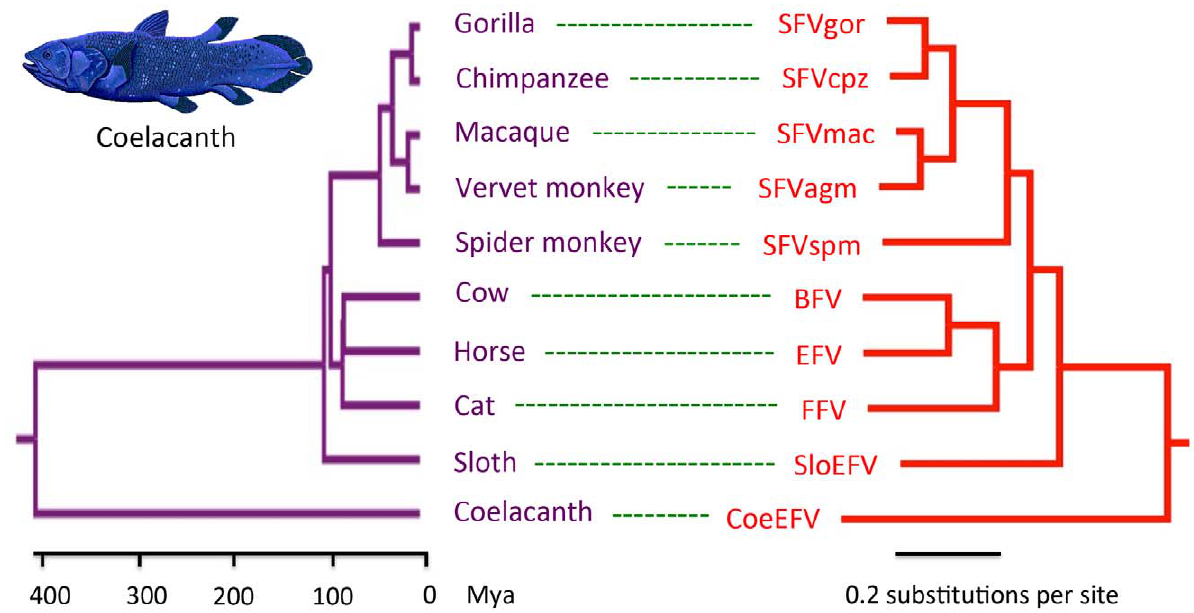
Figure 4. Phylogenetic congruence of foamy viruses (right) and their hosts (left). Associations between foamy viruses and their hosts are indicated by connecting lines. The scale of the host phylogeny (left) indicates millions of years. The foamy virus phylogeny (right) is the 50% majority- rule consensus tree inferred from conserved region of foamy virus and Class III retrovirus Pol protein alignment with MrBayes 3.1.2. The Bayesian phylogeny is well supported with all nodes showing posterior probability of 1.00. Branch lengths are in expected amino acid changes per site. Coelacanth image courtesy of Robbie Cada. doi:10.1371/journal.ppat.1002790.g004 clades (walleye dermal sarcoma virus (WSDV) and snakehead retrovirus (SnRV), respectively, blue asterisks), (Figs. 3, S3). This pattern provides additional evidence of a marine origin and long- term coevolution of these major retroviral lineages. However, to